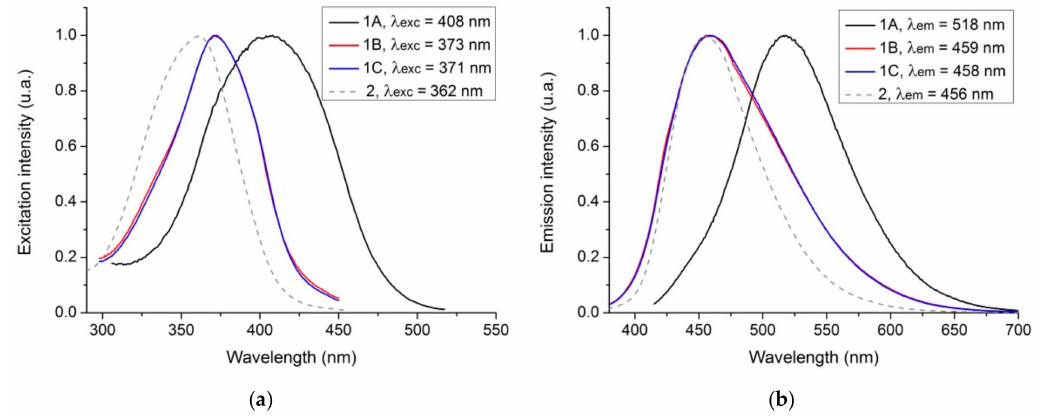
Figure 3. Fluorescence ( a ) excitation spectra and ( b ) emission spectra of carbon dots 1A, 1B, 1C, and 2. Data were